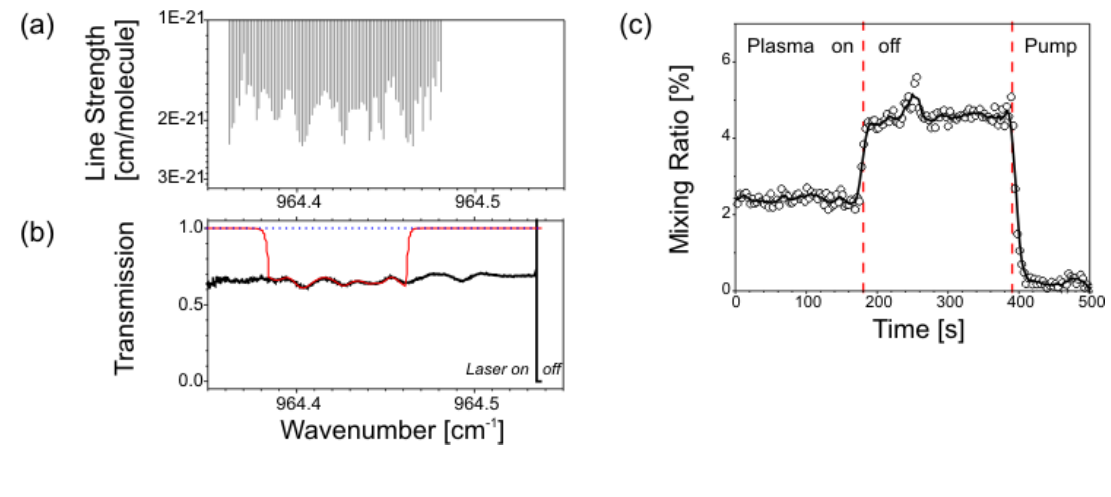
(b) (adapted and enlarged from